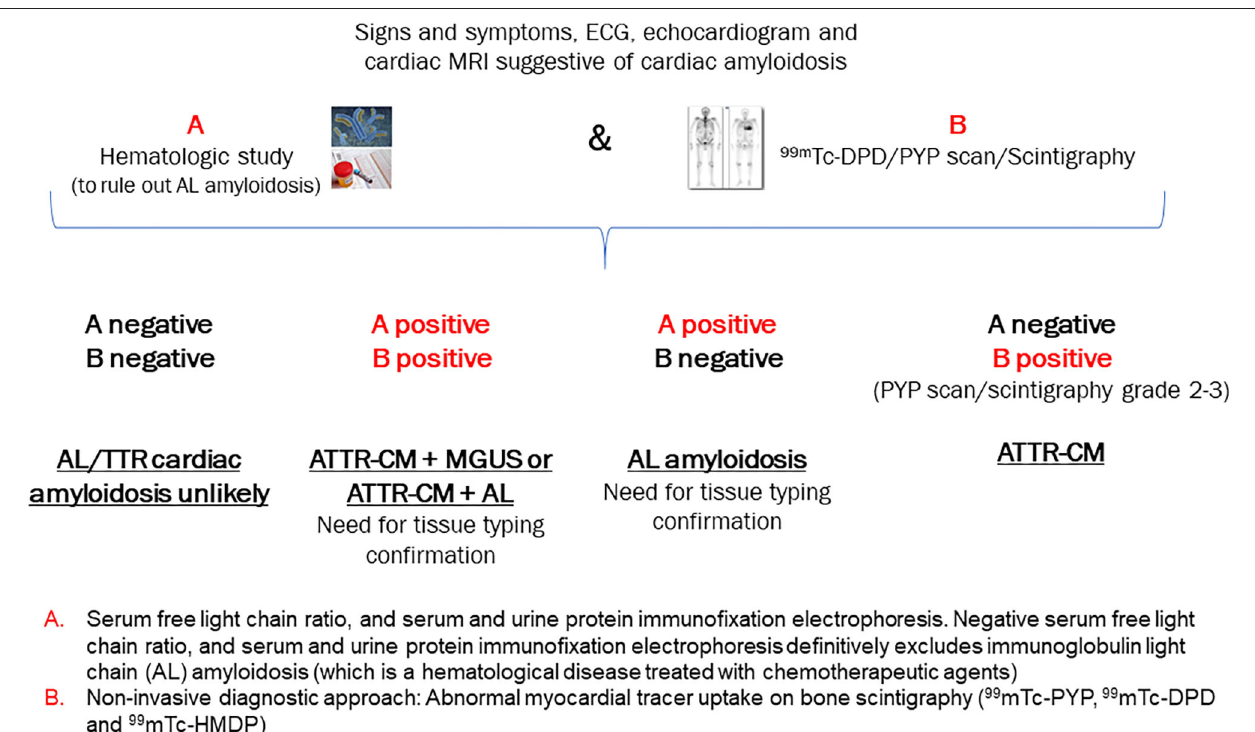
FIGURE 2 | Algorithm for the non-invasive diagnosis of ATTR-CM. [Adapted from Gillmore 2016] (21). AL, light-chain amyloidosis; ATTR, transthyretin amyloidosis; ECG, electrocardiogram; MRI, magnetic resonance imaging; PYP, pyrophosphate; 99m TC-DPD, technetium-99m-3, 3-diphosphono-1, 2 propanodicarboxylic acid.